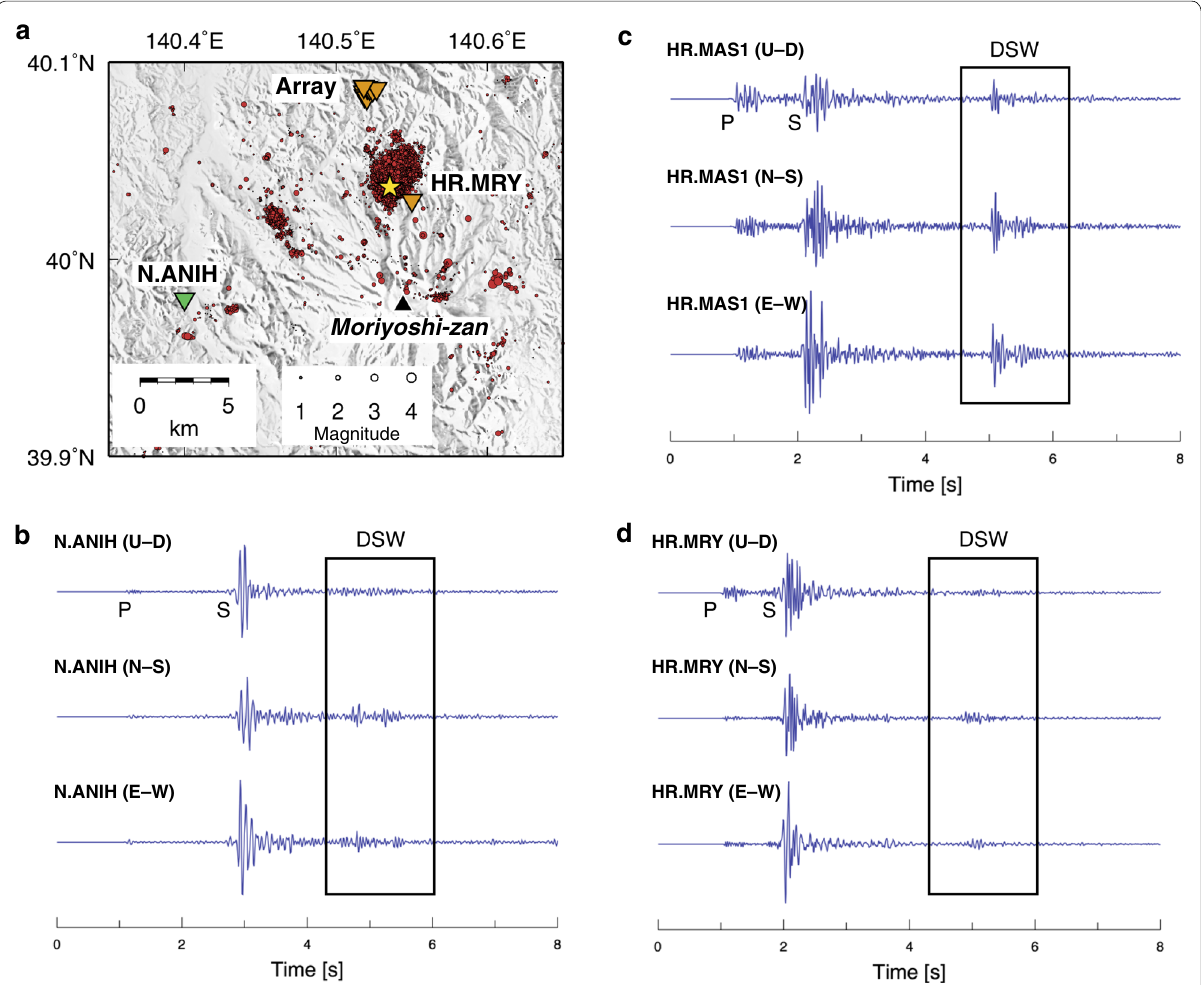
Fig. 2 An example of DSW (distinct scattered wave packets). a Location of the epicenter (yellow star) and stations (inverted triangles). Red circles and black triangle denote the epicenter of earthquakes and the location of the Moriyoshi-zan volcano, respectively. b – d Three-component band-pass filtered (8–32 Hz) seismograms from the earthquake (November 9, 2012, 03:46:37 JST (UT HR.MAS1 is one of the component stations of the array. The amplitude is normalized to the maximum among the three components. DSW appears in the black